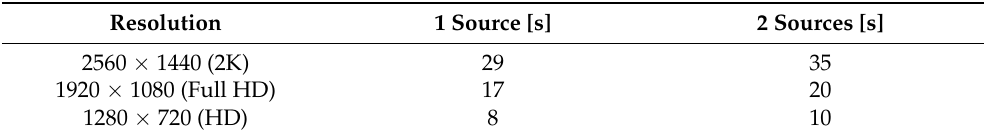
Table 6. Test of time consumption for different resolutions of the heat map and a different number of